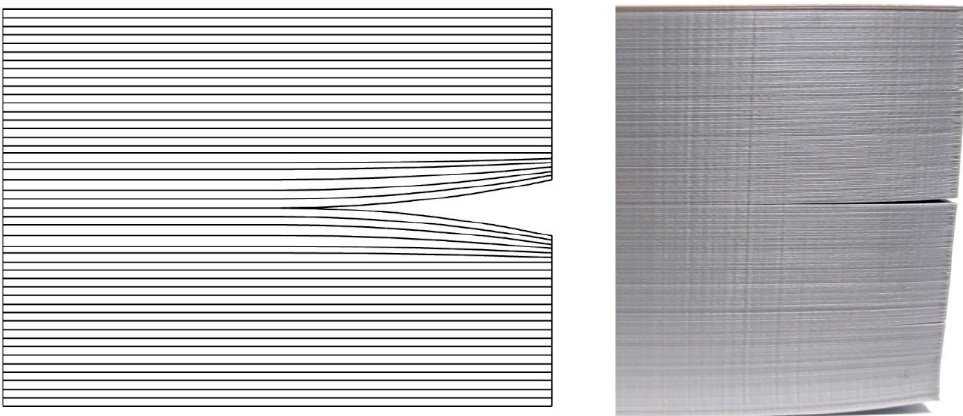
Figure 6. Crack stratifications of filament layers. ( Left ) : schema; ( Right ) : photo of real printout.